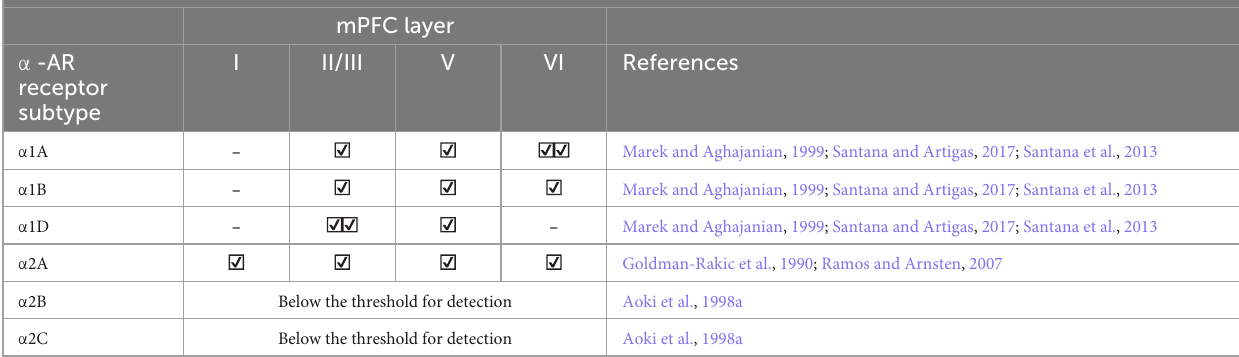
TABLE 1A Laminar and cellular distribution of α -adrenergic receptors (AR) in the medial prefrontal cortex (mPFC).